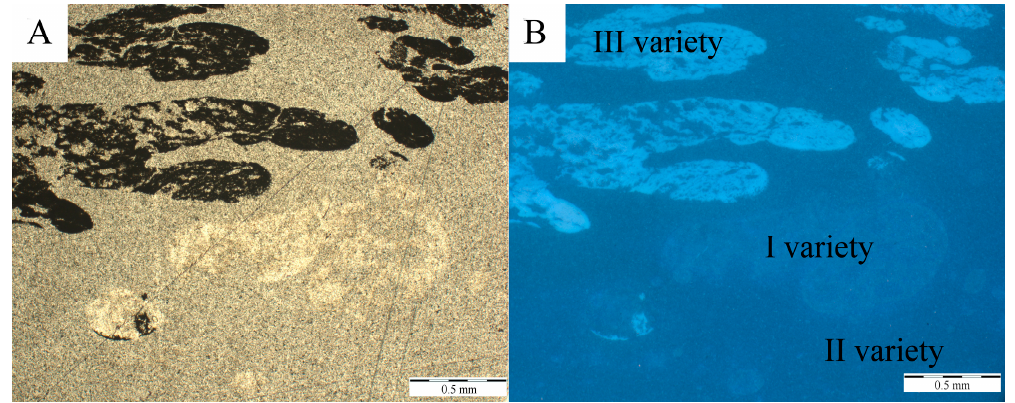
Figure 7. Microscopic image of fossil resins from the island of Sumatra, 1N ( A ); UV-epifluorescence ( B ).